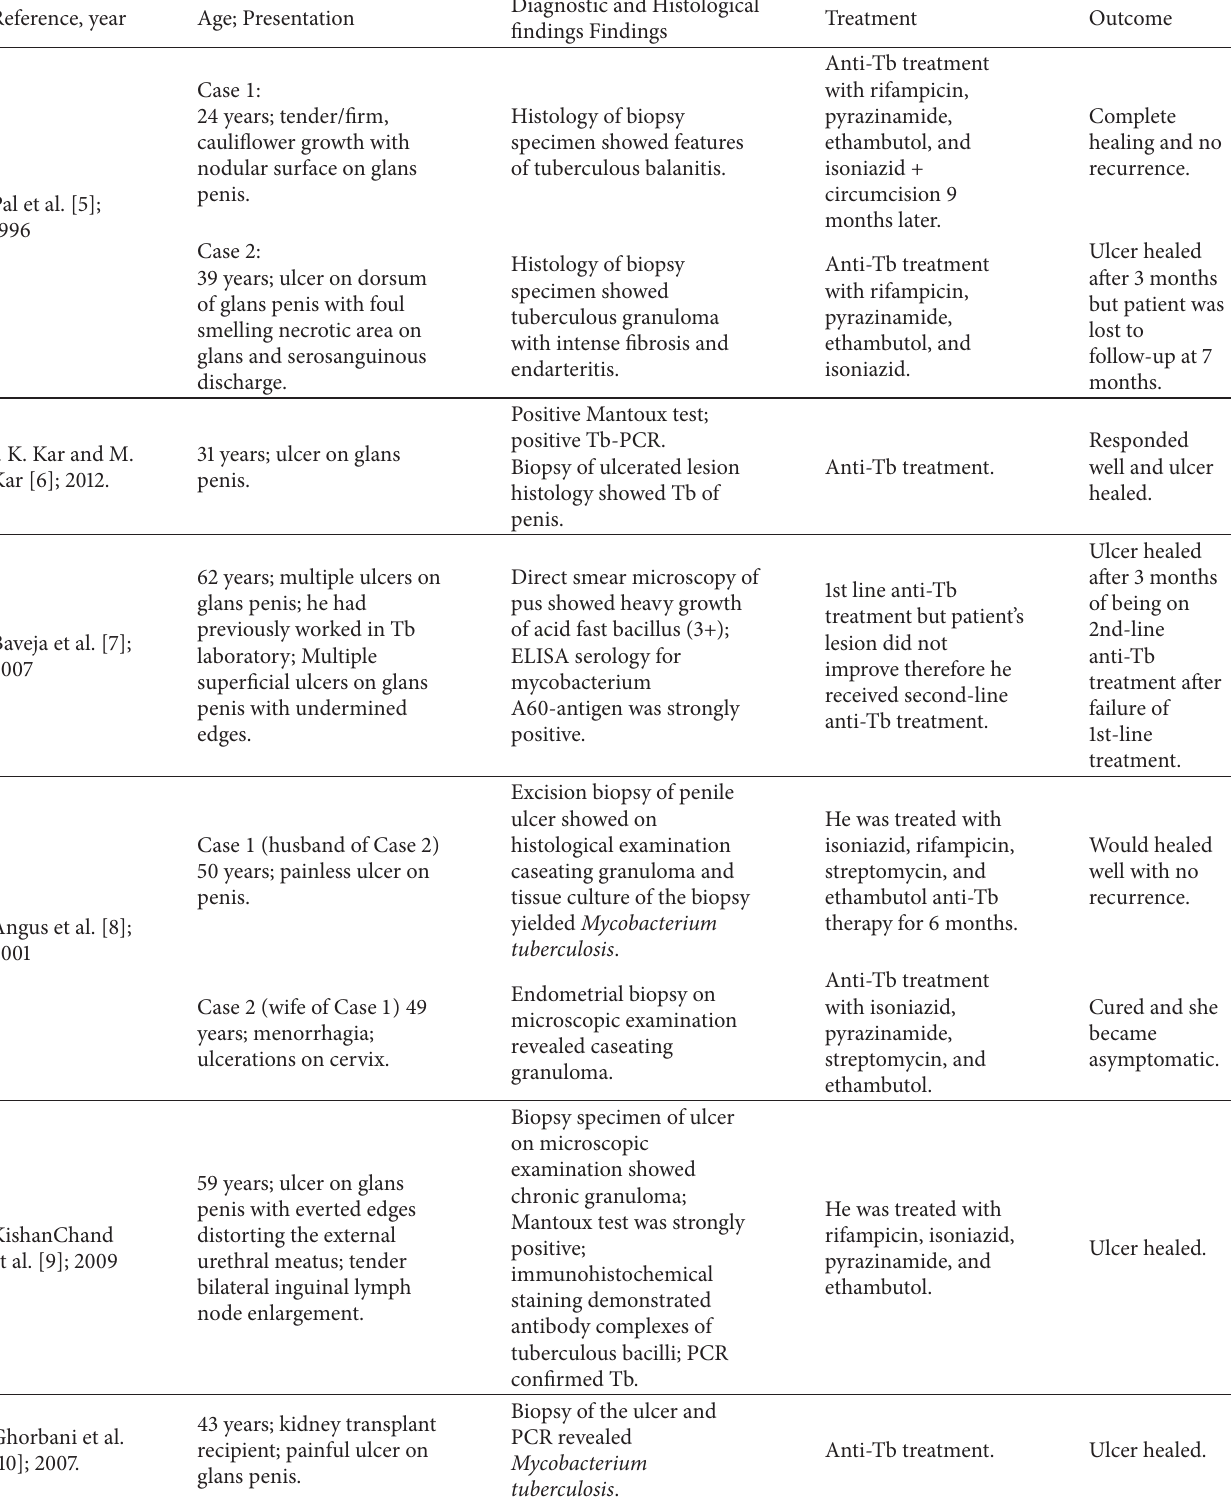
Table 1: List and summary of the clinical findings of some of the reported cases of tuberculosis of